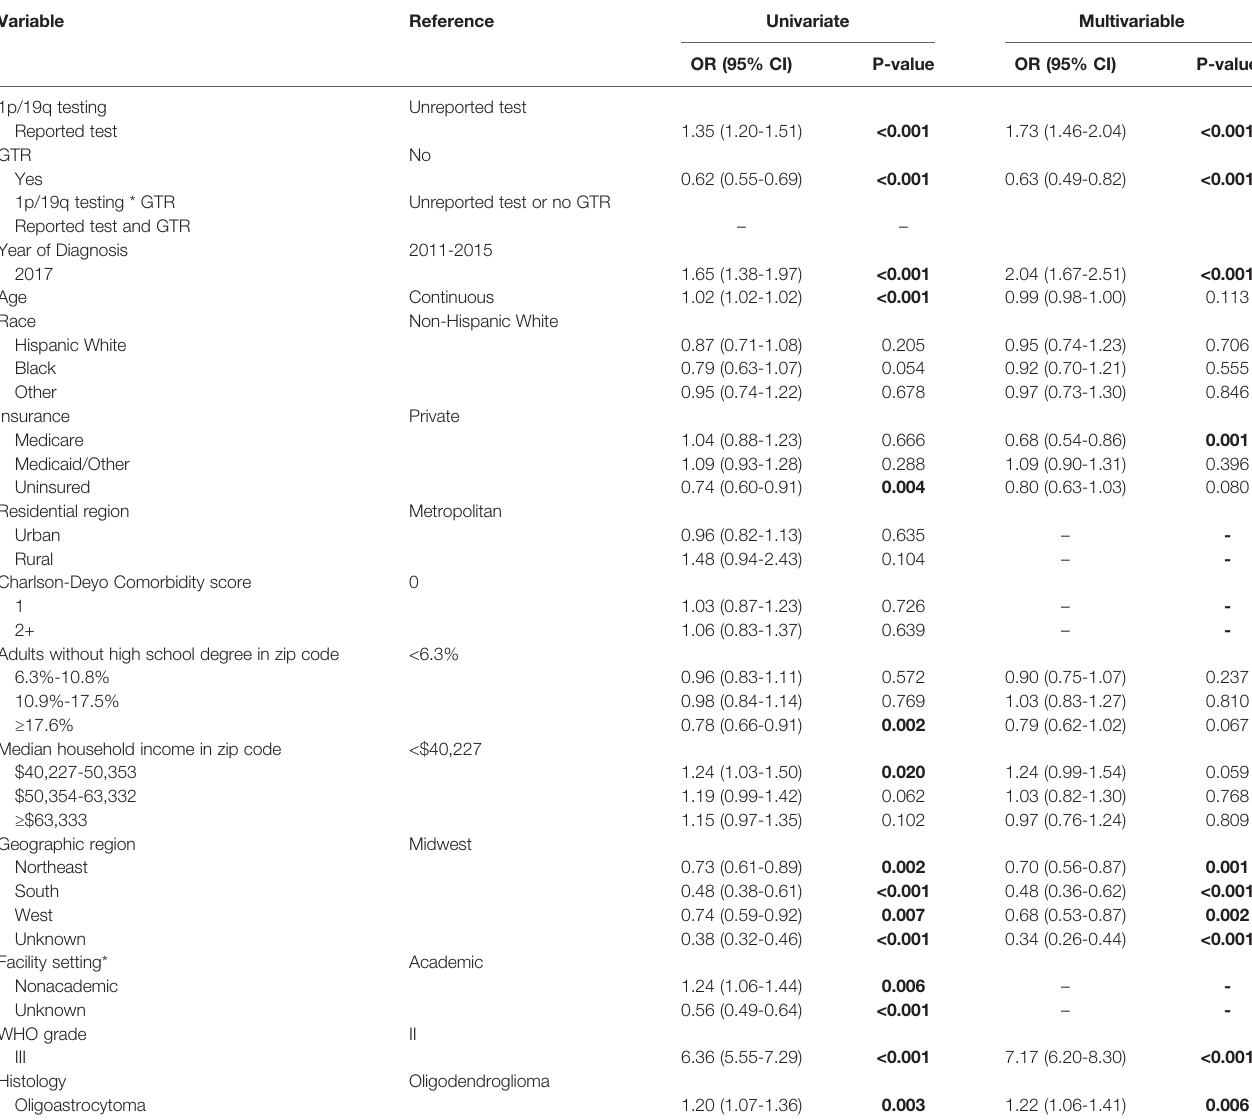
TABLE 6 | Univariate and multivariable logistic regression evaluating factors associated with receipt of adjuvant treatment.